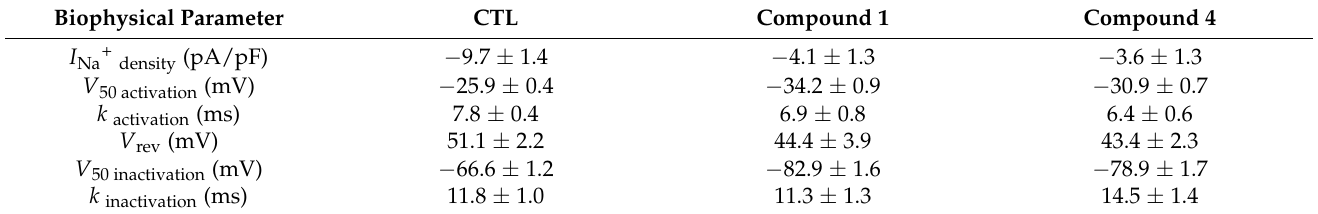
Table 2. Voltage parameters of SW620-Na V 1.5 sodium channels in the presence of small-molecule